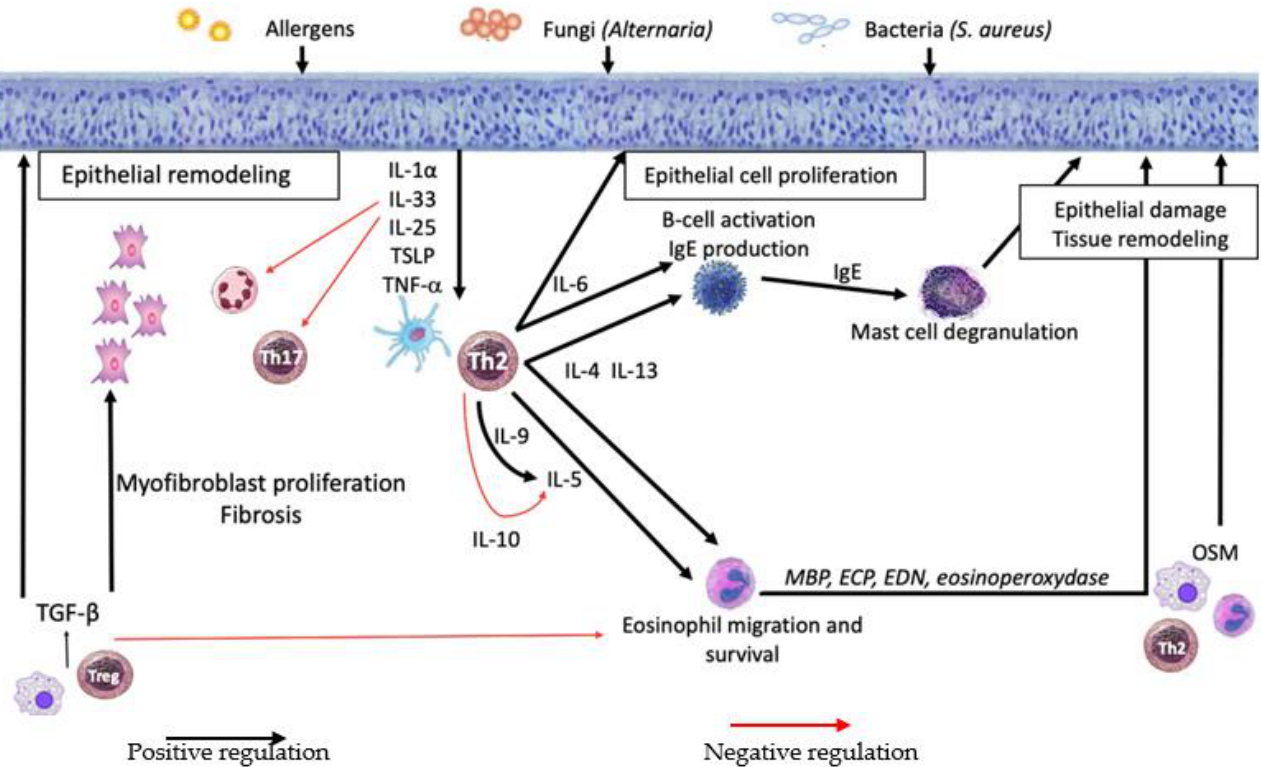
Figure 1. Summary of cytokines network involved in CRSwNP. OSM: oncostatin M; MBP: major basic protein; ECP: eosinophilic cationic protein; EDN: eosinophil-derived neurotoxin. Following an aggression of the nasal epithelium by S. aureus , Alternaria or allergens, a Th2 inflammatory response is induced by IL-1α, IL-33, IL-25, TSLP and TNFα. IL-6, IL-4, and IL-13 cause IgE production and mast cell degranulation, and IL-5 causes eosinophil activation and survival. These phenomena, associated with the action of OSM and TGF-β, lead to tissue remodeling characterized by alteration of the epithelium and fibrosis.